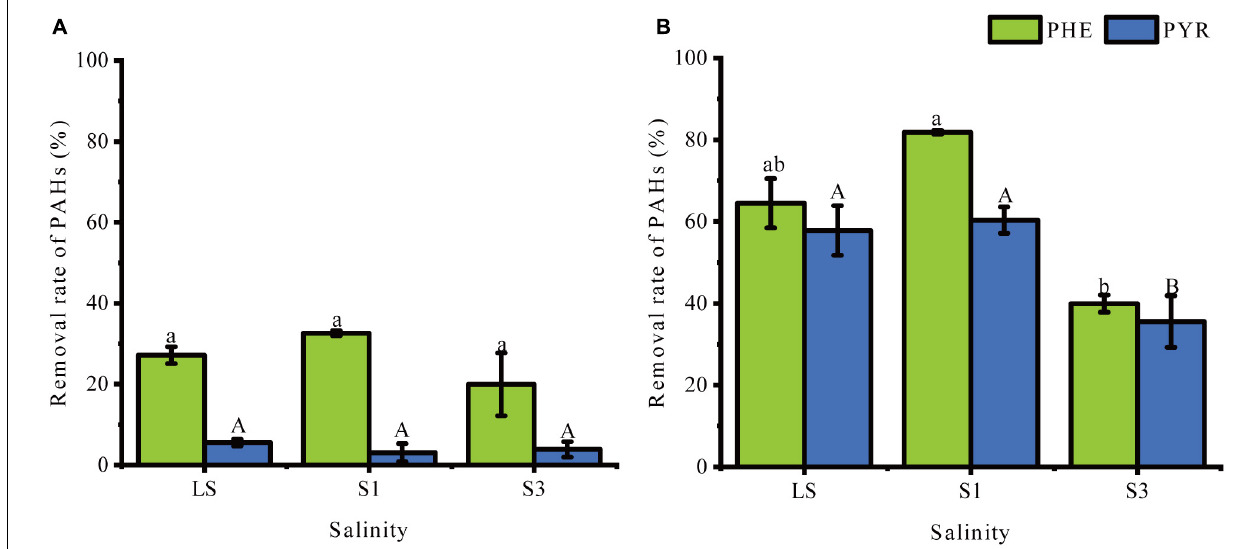
FIGURE 1 | Percent removal of PHE and PYR in treatments under different salinities. (A) the 7 th day, (B) the 30 th day. Error bars represent standard deviations of triplicate samples. Different letters indicate significant differences between the different salinity treatments at P <